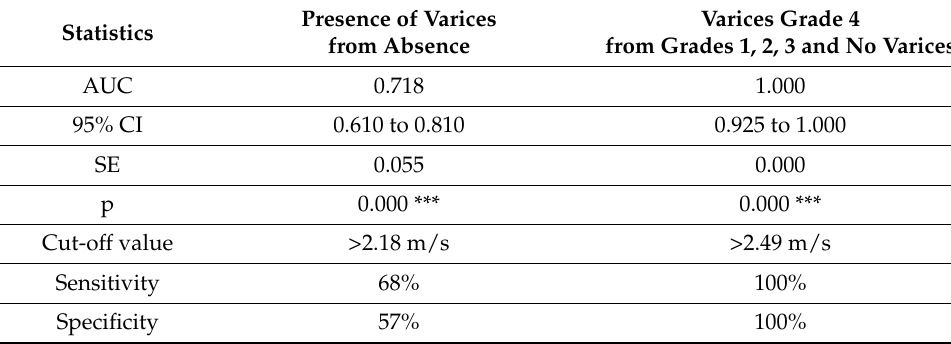
Table 3. Cut-off values for the diagnosis of EVs and